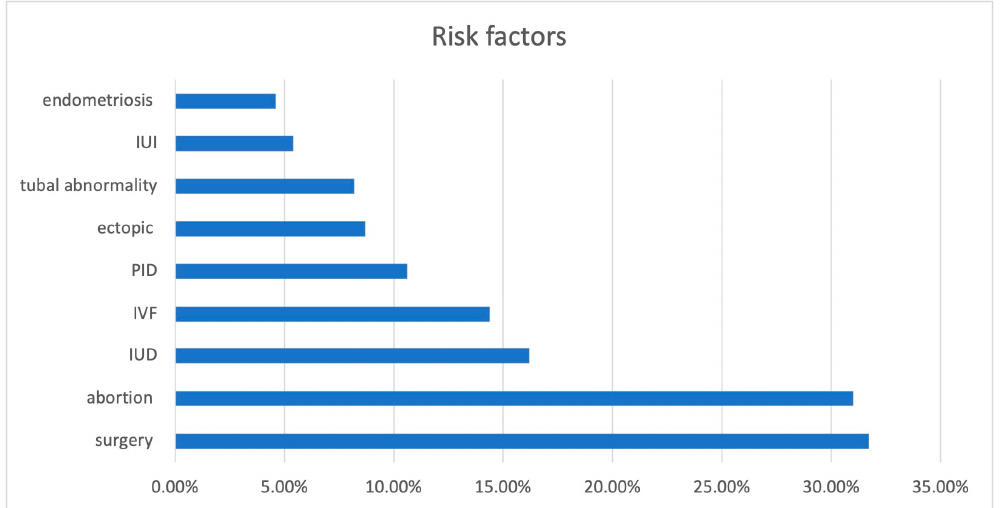
Figure 3. Incidences of previous ectopic pregnancies, IVF, IUI, tubal surgery, endometriosis, pelvic surgery, PID or IUD in women with ovarian pregnancies.